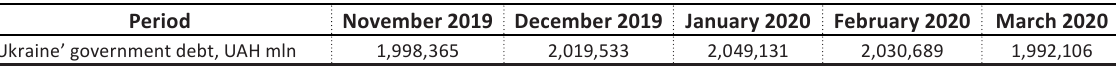
Table 2. Forecast of the government debt amount in Ukraine, UAH mln